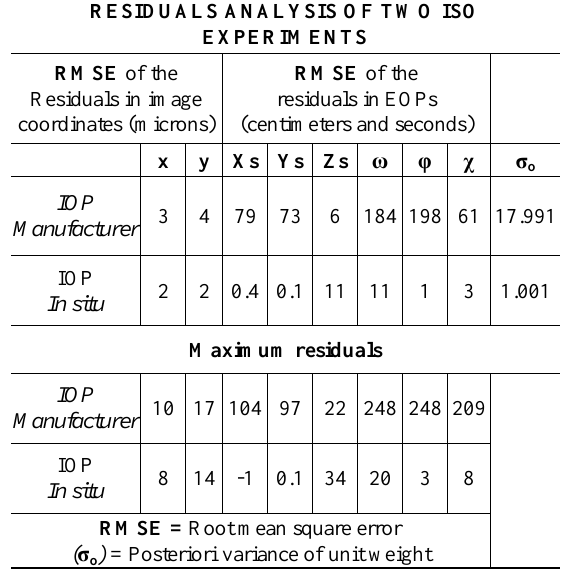
Figure 4: Residuals of the image orientations obtained in the Table 3. Main results of the residuals analyses of the two ISO ISO experiment using IOP in situ camera experiments